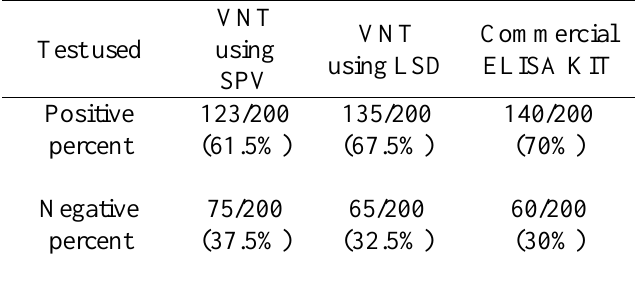
Table 6: Percent of positive and negative samples tested by VNT using SPV and LSDV compared to ELISA Kit using field samples: Test